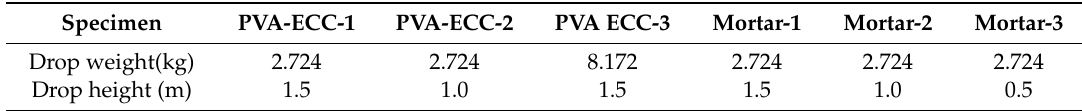
Table 5. Detailed impact information for each beam specimen.